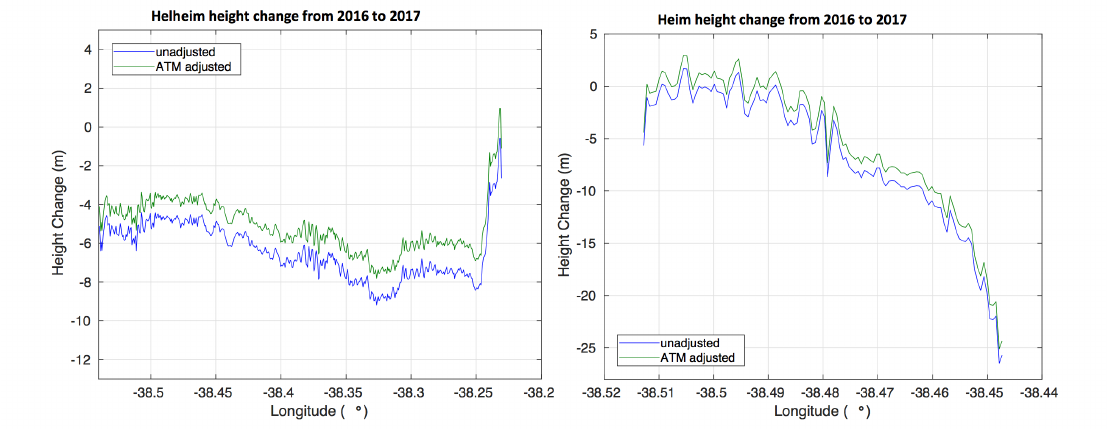
Figure 11. Height change as a function of longitude for Helheim ( left ) and Heim ( right ) glaciers without correction (blue) and with correction by comparison with ATM data (green). Averages are computed only over regions with velocities greater than 1000 m per year as illustrated in Figure